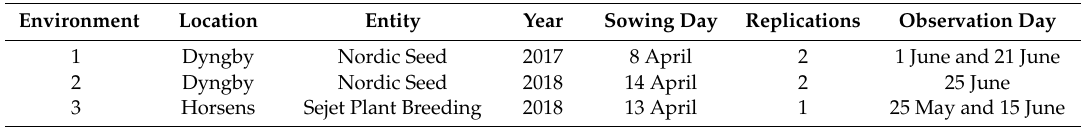
Table 3. Field evaluation